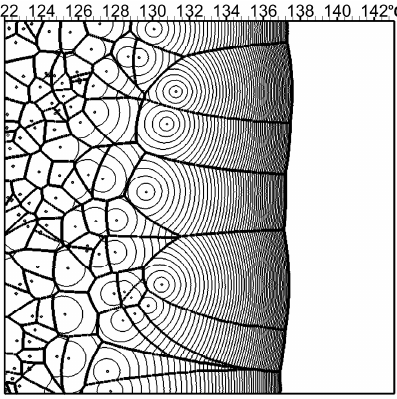
Figure 14. Positions of the crystallization front in iPP film during crystallization in the uniaxial linear temperature field.